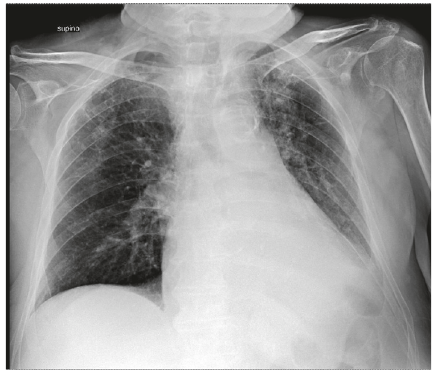
Figure 3: Chest radiography after bronchoscopy.